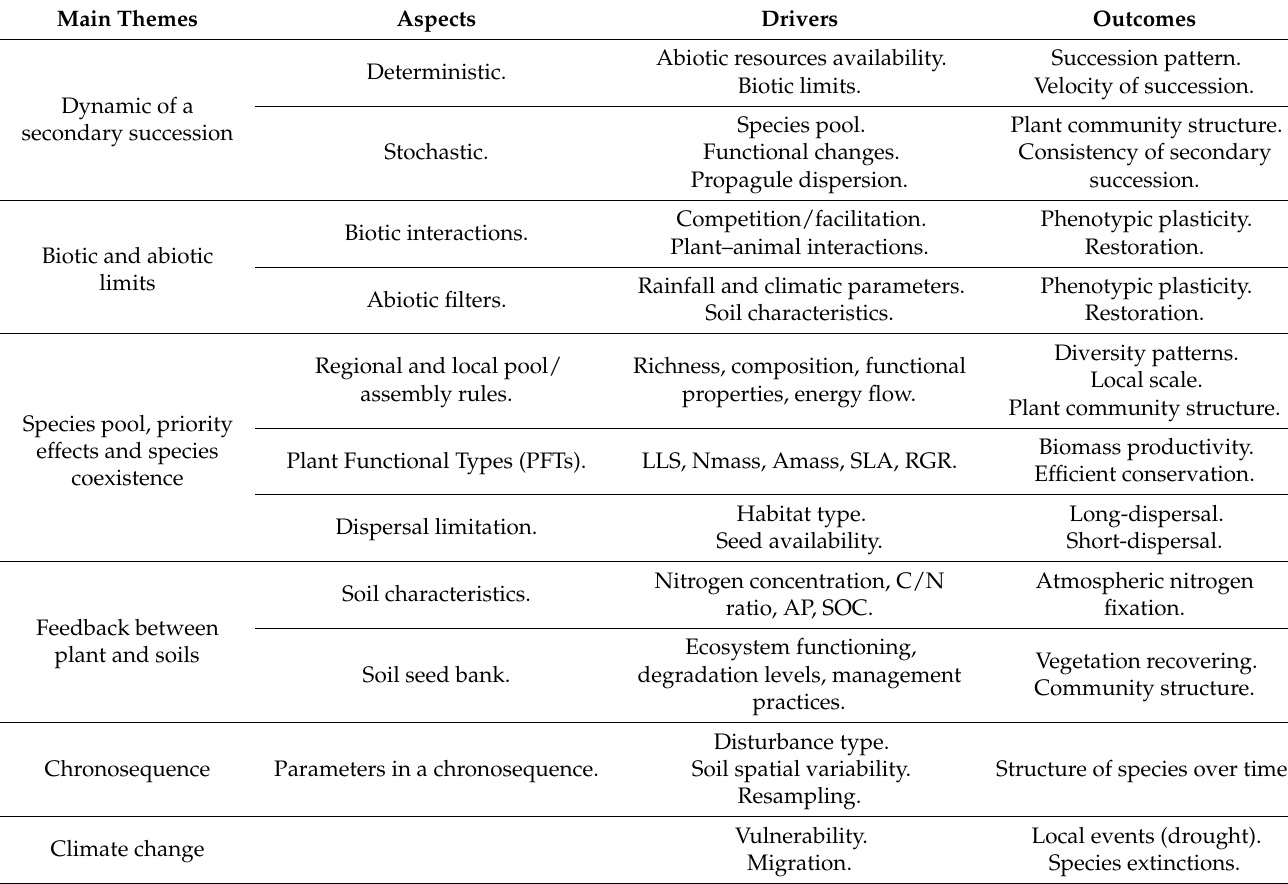
Table 1. Summary of main themes, important aspects, drivers and outcomes enclosed in the revised literature for secondary succession. Abbreviations are: LLS (Leaf Life span); Nmass (area-based leaf N content); Amass (species mass); SLA (specific leaf area); RGR (plant Relative Growth Rate); C (carbon); N (nitrogen); AP (available Phosphorus); SOC (soil organic